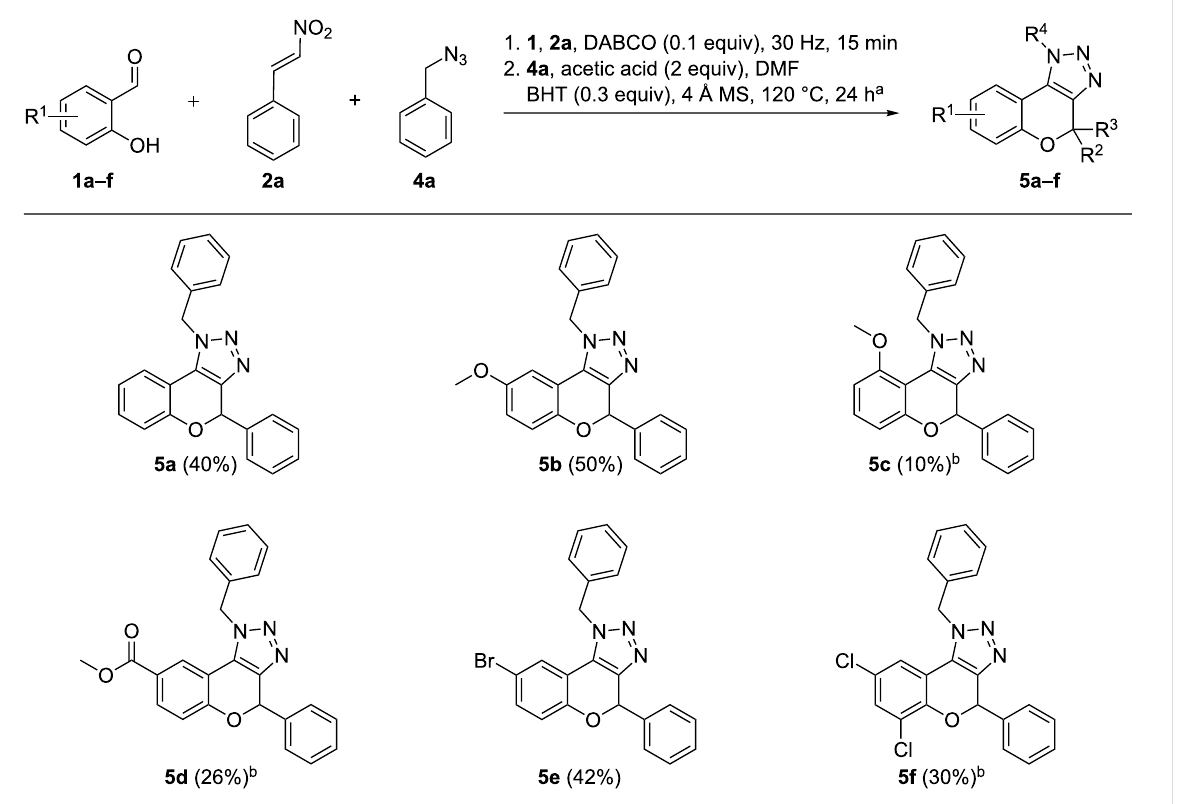
Figure 2: Generality of products obtained via the two-pot mechanochemical procedure, varying the salicylaldehydes 1a – f . a Reaction conditions for ball milling procedure, followed by 1,3-dipolar cycloaddition in a reaction vial: 1. 1 (1.2 equiv), 2a (1 equiv), DABCO (0.1 equiv), 15 min, 30 Hz;